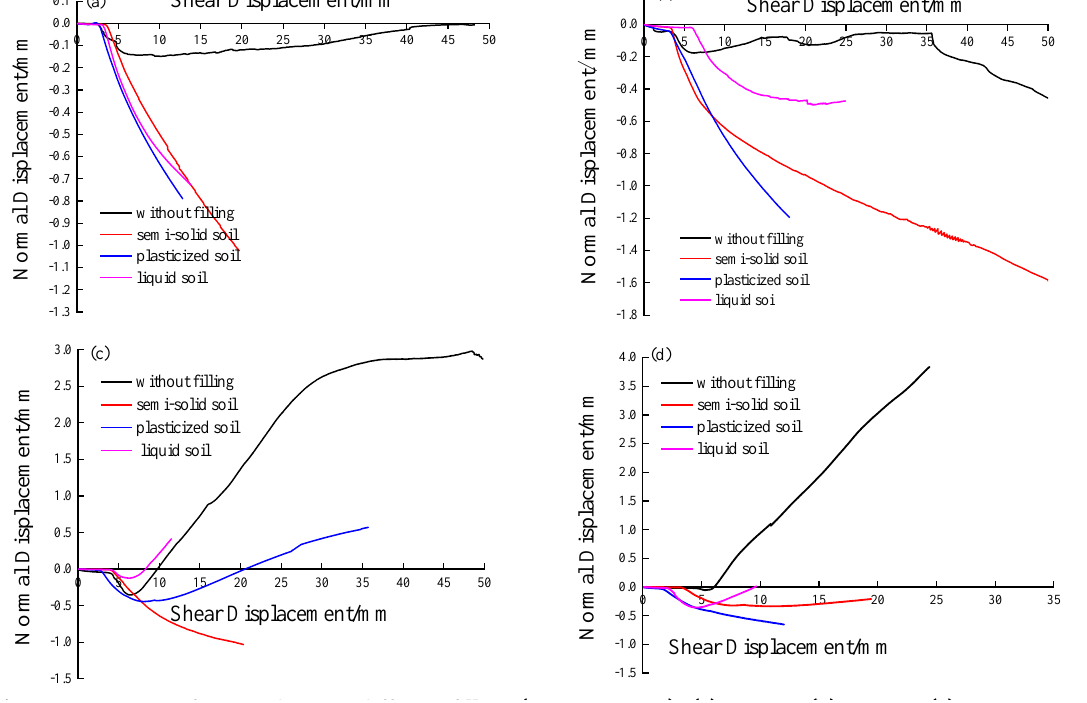
Fig.13. Test curve of ND and SD in different filling (NS is 1.5MPa): (a) JRC=3; (b) JRC=7; (c) JRC=15; and (d) JRC=19.